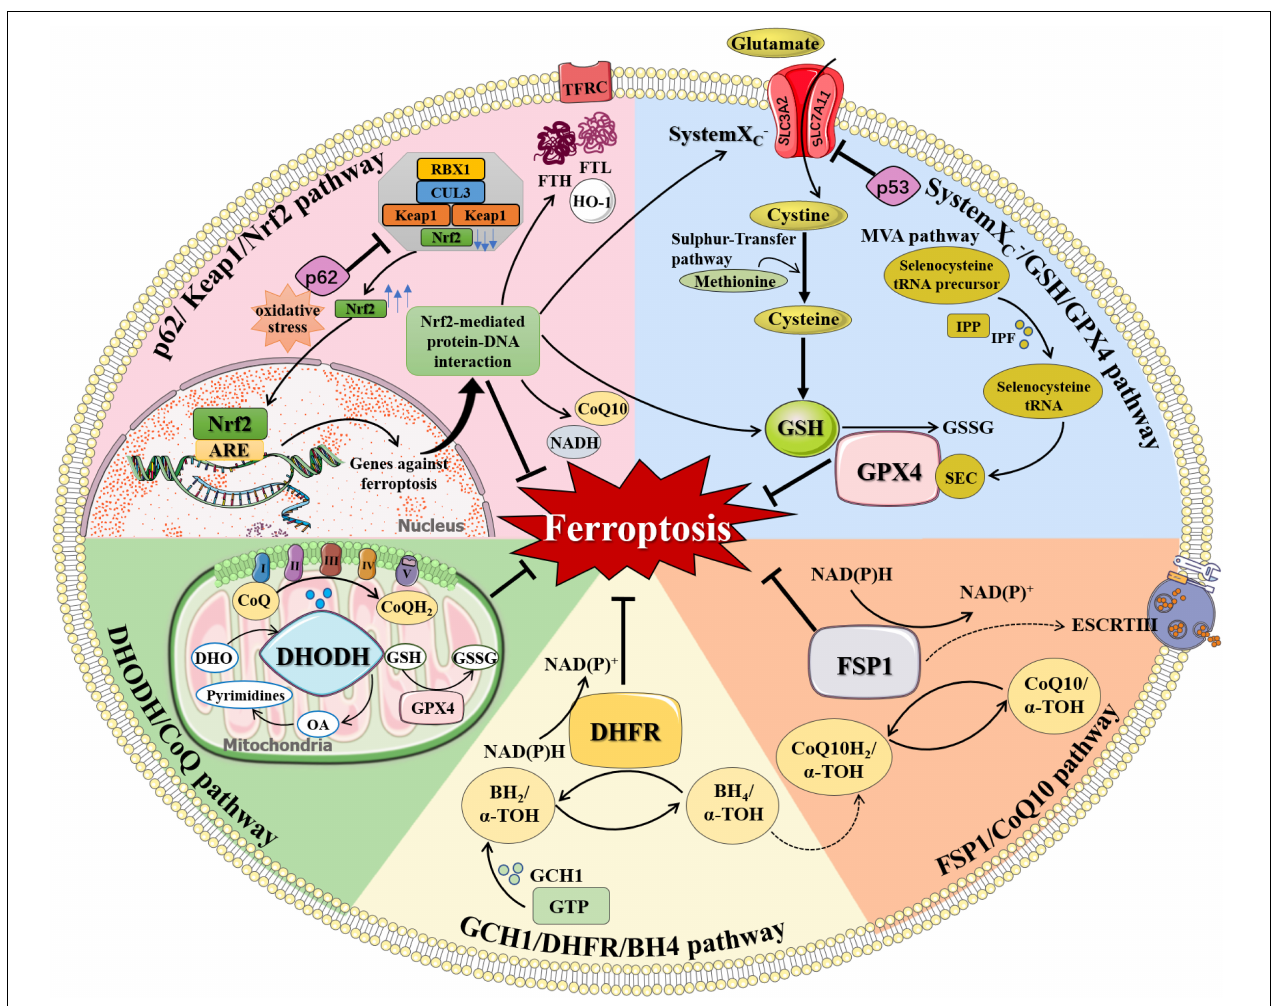
FIGURE 2 | The regulation of ferroptosis. Multiple pathways inhibit ferroptosis by resisting oxidative distress and inhibiting lipid peroxidation, including systemX C − /GSH/GPX4 pathway, FSP1/CoQ10 pathway, GCH1/DHFR/BH4 pathway, DHODH/CoQ pathway, and p62/Keap1/Nrf2 pathway. (1) systemX C - /GSH/GPX4 pathway: systemX C - consists of SLC7A11 and SLC3A2 and is capable to exchange glutamate and cystine equally. Cystine is obtained from methionine through the Sulfur-transfer pathway and then converted to cysteine intracellularly to generate GSH. Selenoprotein GPX4 detects GSH, leading to the reduction of lipid hydroperoxides to lipid alcohols and the simultaneous oxidization of two GSH into oxidized GSSG. IPP, produced by the MVA pathway, transfers isopentyl groups to isopentyl transferases-catalyzed Sec-tRNA precursors which mediate the maturation of Sec-tRNAs responsible for Sec insertion into GPX4. (2) FSP1/CoQ10 pathway: FSP1 converts CoQ10 to CoQ10H2 using NAD(P)H, which quenches lipid free radicals generated by lipid peroxidation. Membrane-associated protein complex ESCRT-III regulates membrane regeneration through membrane germination and cleavage. FSP1 transported in the plasma membrane can resist ferroptosis by enrolling ESCRT-III to activate the membrane restore mechanism. (3) GCH1/DHFR/BH4 pathway: BH4 is a potent free radical scavenger that exerts antioxidant effects in cells. The interconversion between the oxidation and reduction forms of BH4 is controlled by two enzymes, GCH1 and DHFR. The synthesis of BH4 by GCH1 expression selectively prevents PUFA-PL depletion-induced membrane lipid remodeling. DHFR is an essential enzyme for BH4 regeneration, and its inhibition may synergize with GPX4 inhibitors to induce ferroptosis. BH4 can also quench ROS by promoting the synthesis of CoQ10. (4) DHODH/CoQ pathway: DHODH is an enzyme present on the inner surface of mitochondria that catalyzes substrates DHO to produce OA. DHODH cooperates with mitochondrial GPX4 to regulate mitochondrial ferroptosis by reducing CoQ to CoQH 2 on the mitochondrial intima independently of the cytoplasmic GPX4 or FSP1 pathways. (5) p62/Keap1/Nrf2 pathway: Under oxidative distress conditions, p62 prevents the degradation of Nrf2 in the Keap1-CUL3-RBX1 E3 ubiquitin ligase complex. Nrf2 undergoes nuclear translocation and binds to ARE to initiate transcription of multiple cytoprotective genes against ferroptosis. Nrf2-mediated protein-DNA interaction regulates the expression of FTH, FTL, FPN, TfR, HO-1, and so on for controlling cellular iron metabolism, promoting SLC7A11 expression, and increasing the production of NADPH, GSH, and CoQ10 to enhance the antioxidant capacity of cells. α -TOH, α -tocopherol; ARE, antioxidant response element; BH 2 , dihydrobiopterin; BH4, tetrahydrobiopterin; CoQ, coenzyme Q; CoQ10, coenzyme Q10; CoQH 2 , reduced coenzyme Q; CUL3, cullin 3; DHFR, dihydrofolate reductase; DHO, dihydroorotate acid; DHODH, dihydroorotate dehydrogenase; ESCRT-III, endosome sorting complex; FTH, ferritin heavy chain; FTL, ferritin light chain; FSP1, ferroptosis suppressor protein 1; GCH1, GTP cyclohydrolase-1; GPX4, glutathione peroxidase 4; GSH, glutathione; GSSG, oxidized glutathione; GTP, guanosine triphosphate; HO-1, heme oxygenase 1; IPF, isopentenyl transferase; IPP, isopentenyl pyrophosphate; Keap1, KELCH-ECH-associated protein 1; MVA pathway, mevalonate Regulation pathway; NADH, reduced nicotinamide adenine dinucleotide; NAD(P) + , oxidized nicotinamide adenine dinucleotide (phosphate); NAD(P)H, reduced nicotinamide adenine dinucleotide (phosphate); Nrf2, nuclear factor 2-related erythroid factor 2; OA, orotate; RBX1, RING-box protein 1; Sec, selenocysteine; SLC3A2, solute carrier family 3 member 2; SLC7A11, solute carrier family 7 member 11; TFRC, transferrin receptor.